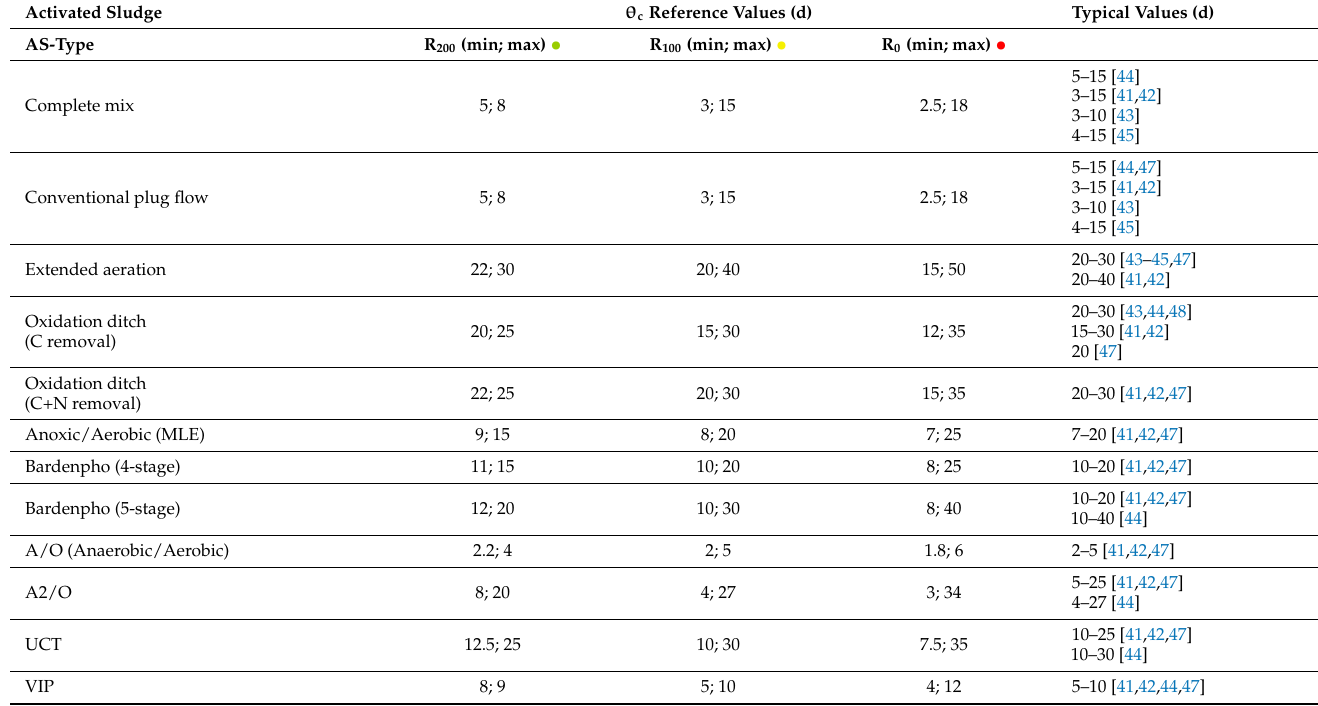
Table 4. The reference values for the solids retention time in AS